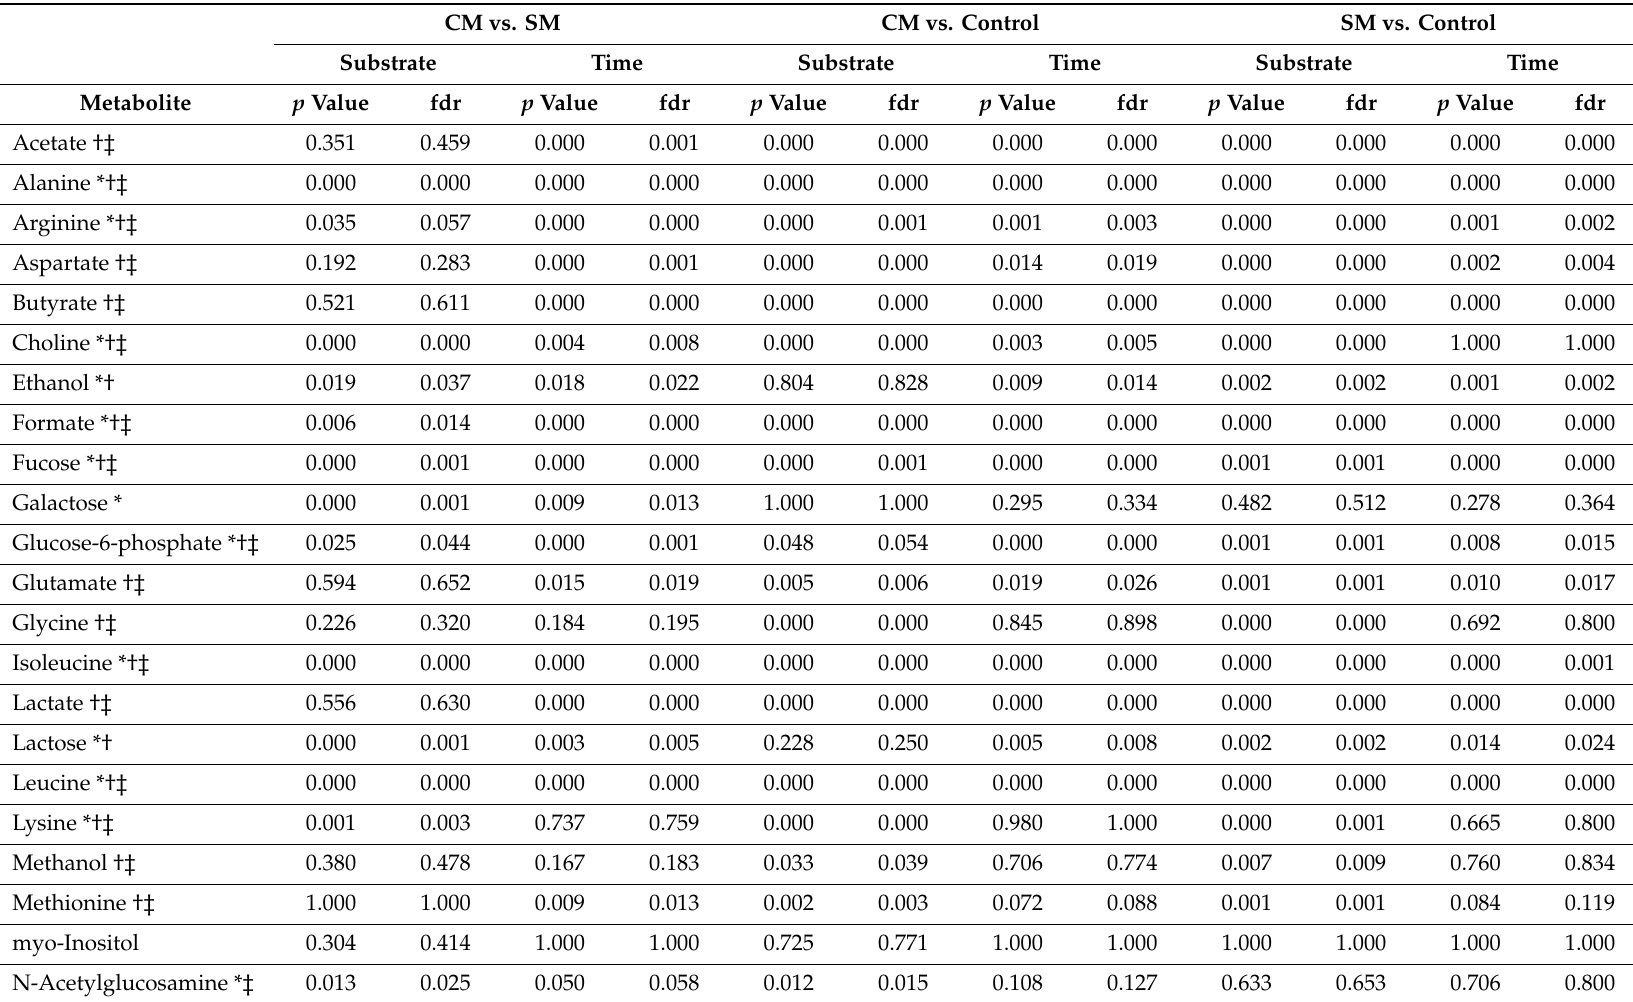
Table A4. Metabolites detected by NMR in one-month-old fecal fermentations, analyzed using